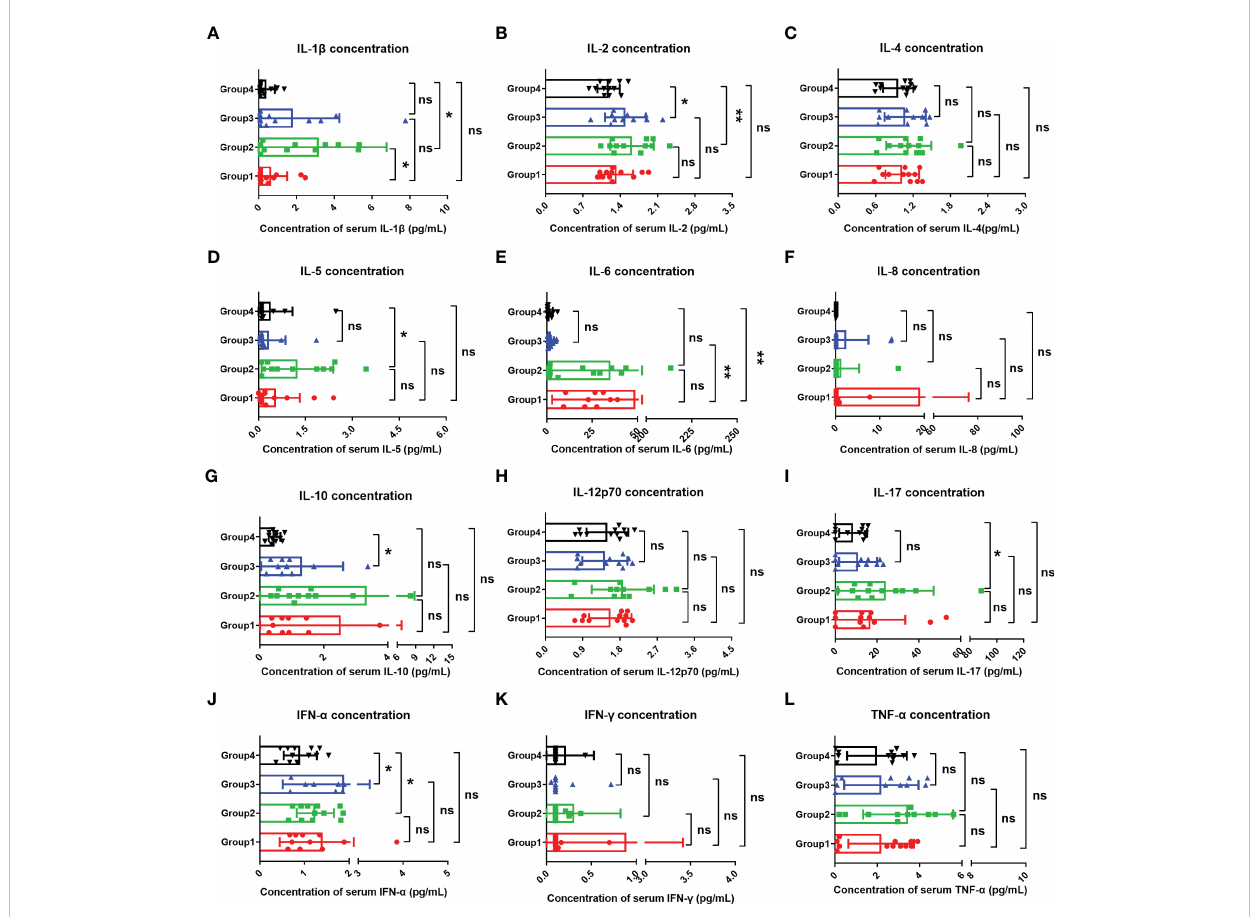
FIGURE 4 Comparisons of cytokines in four groups. The comparisons of overall IL-1 b (A) , IL-2 (B) , IL-4 (C) , IL-5 (D) , IL-6 (E) , IL-8 (F) , IL-10 (G) , IL-12p70 (H) , IL-17 (I) , IFN- a (J) , IFN- g (K) , and TNF- a (L) between four groups during clinical observation. Points in each bar represent four subjects ’ data from different time points. ns, not statistically signi fi cant. *p <0.05, **p